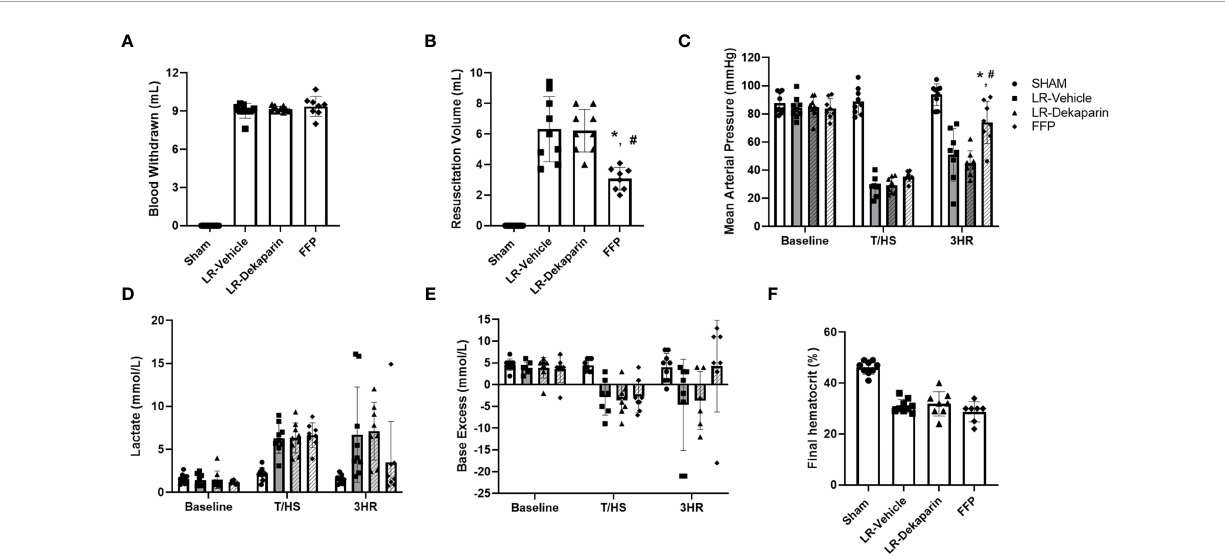
FIGURE 3 Dekaparin does not alter induction or LR-mediated reversal of hemorrhagic shock. (A) The volume of blood withdrawn in mL required to reach a target mean arterial pressure (MAP) of 35 mmHg. (B) The volume (mL) of resuscitation fl uid required to restore hemodynamic stability. (C) MAP was continuously monitored using PowerLab. (D) Blood lactate (mmol/L), (E) base excess (mmol/L), and (F) hematocrit (%) were measured by iSTAT. Data are expressed as mean with standard deviation. N=9 Sham, N=9 LR-vehicle, N=9 LR-dekaparin, N=8 FFP. * denotes p<0.05 compared to LR-vehicle. # denotes p<0.05 compared to LR-dekaparin. LR, Lactated Ringer's; FFP, fresh frozen plasma; T/HS, trauma and hemorrhagic shock; 3HR, 3 hours after